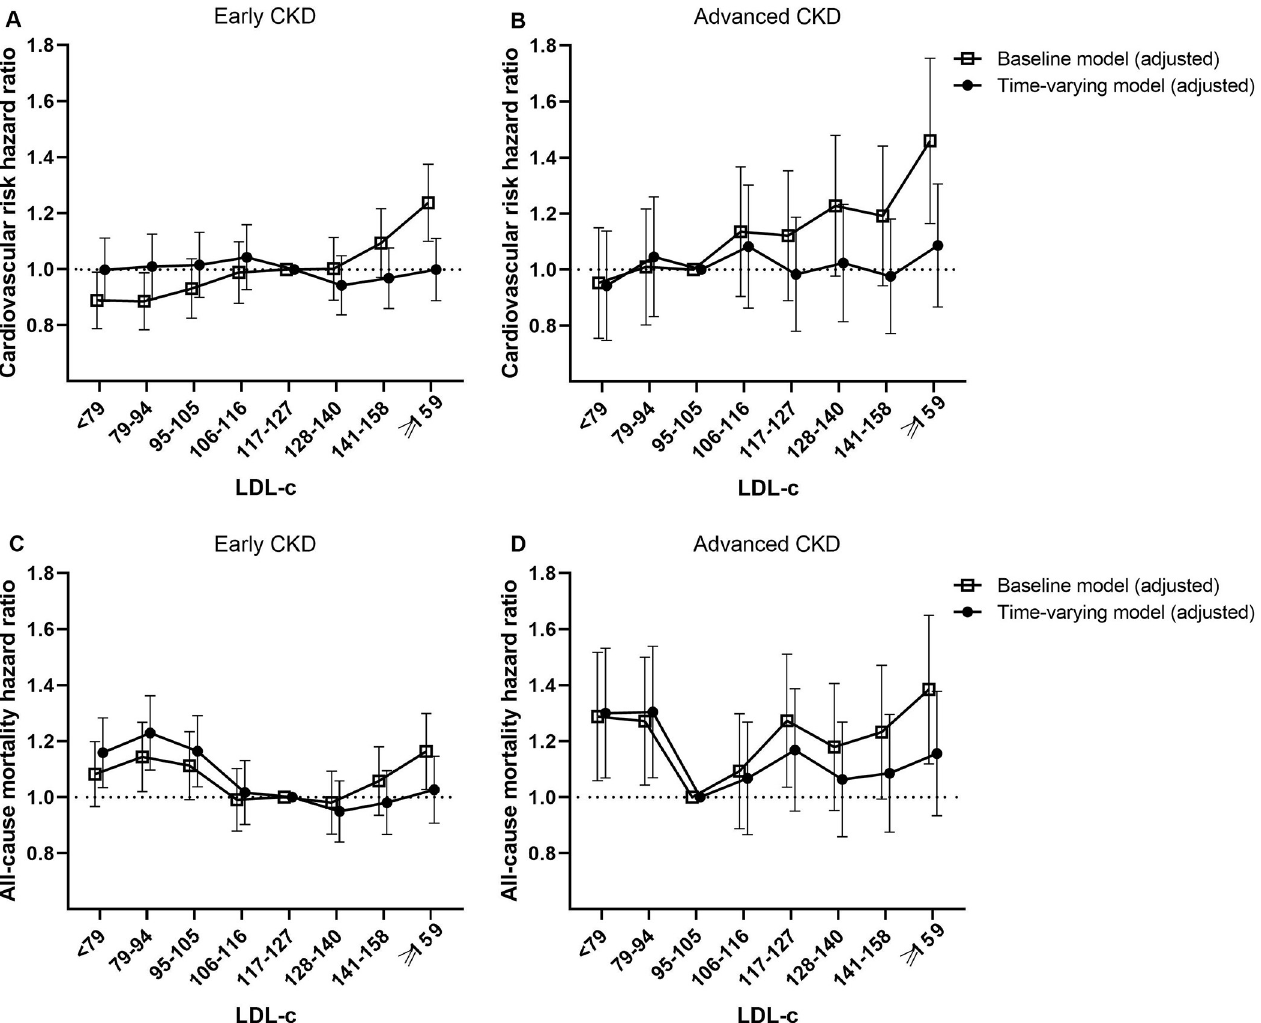
Fig 2. Multivariate-adjusted MACE (A and B) and all-cause mortality (C and D) hazard ratios by serum LDL-c level in early CKD and advanced CKD patients.